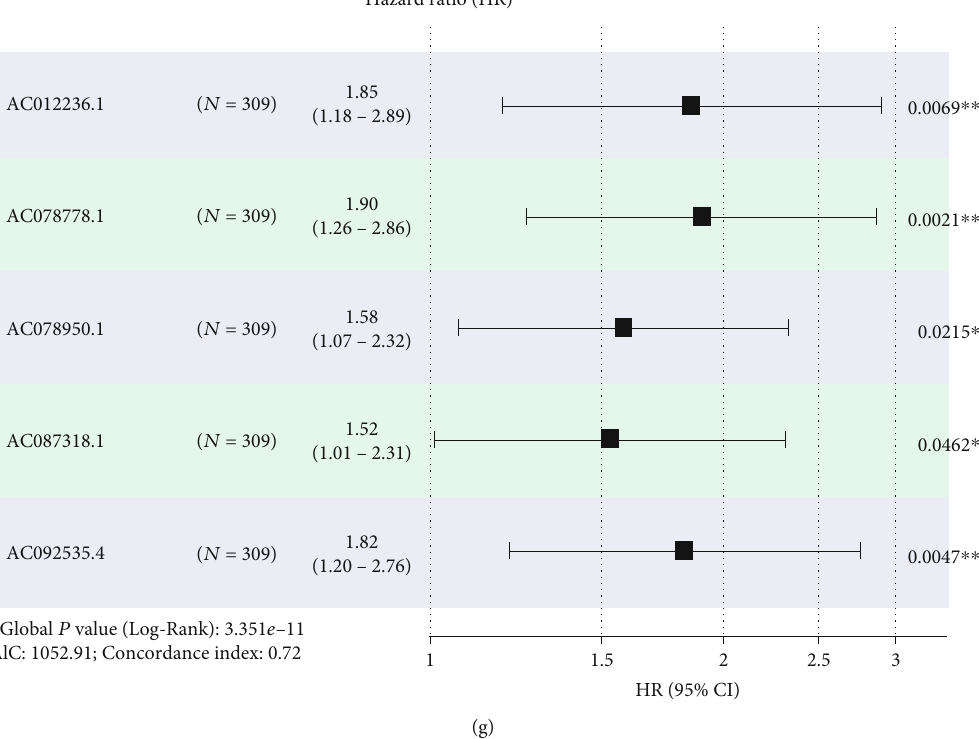
Figure 2: Screening of the DElncRNAs, DETFs ( FDR < 0 : 01 and absolutelog2fold change ð FC Þ > 1 ), and PIDElncRNAs. (a) Volcano plot of DElncRNAs in ccRCC compared with normal tissues. (b) Volcano plot of DETFs in ccRCC compared with normal tissues. (c) Heatmap of top 50 DElncRNAs in ccRCC. (d) Heatmap of 60 DETFs in ccRCC. (e) LASSO coe ffi cient pro fi les of 117 PIDElncRNAs. (f) LASSO regression with tenfold cross validation obtained 14 PIDElncRNAs using minimum lambda value. (g) Multivariate Cox regression analysis of 5 PIDElncRNAs. DElncRNAs: di ff erentially expressed lncRNAs; DETFs: di ff erentially expressed transcription factor genes; PIDElncRNAs: prognostic immune-related di ff erentially expressed lncRNAs; FDR: false discovery rate; ccRCC: clear cell renal cell carcinoma; LASSO: least absolute shrinkage and selection operator. ∗ P < 0 : 05 , ∗∗ P < 0 : 01 , and ∗∗∗ P < 0 : 001 di ff erence in pharmaceutical subgroup (Supplementary material 6: Figure S3A-J). The comparisons of risk score in di ff erent AJCC-stage and grade were also shown in Figure S3K-L (Supplementary material 6), which indicates that the higher risk score, the more advanced of the carcinoma is.